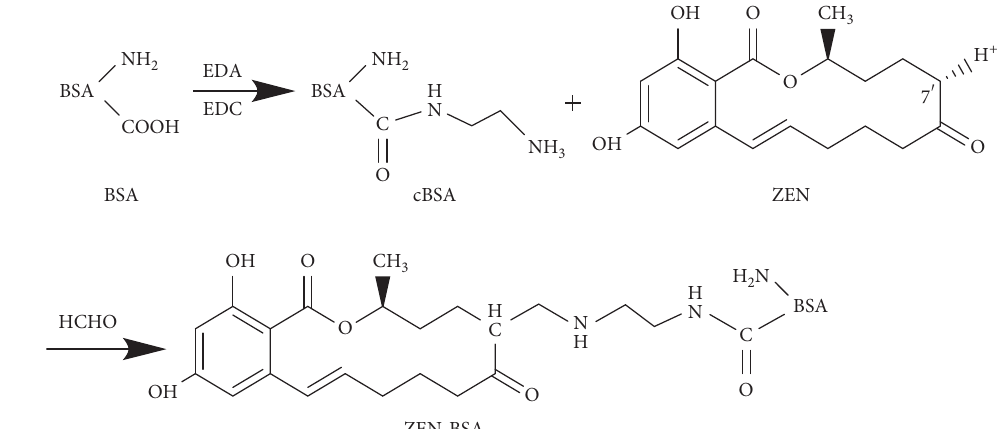
Figure 4: Synthesis route of the ZEN-BSA by the FA method.